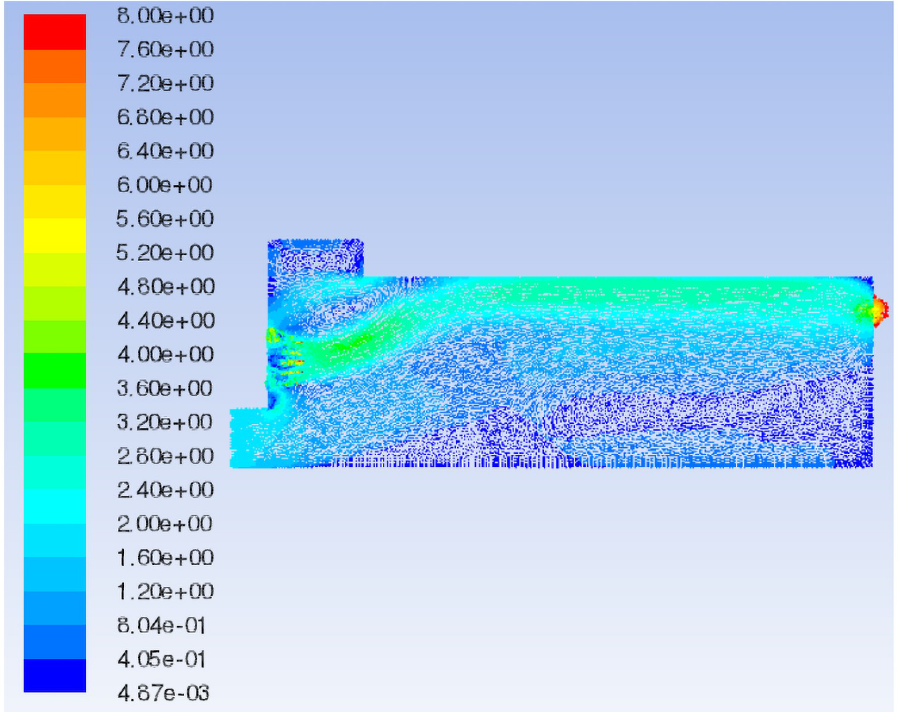
Fig 16. Flow field velocity vector of Model